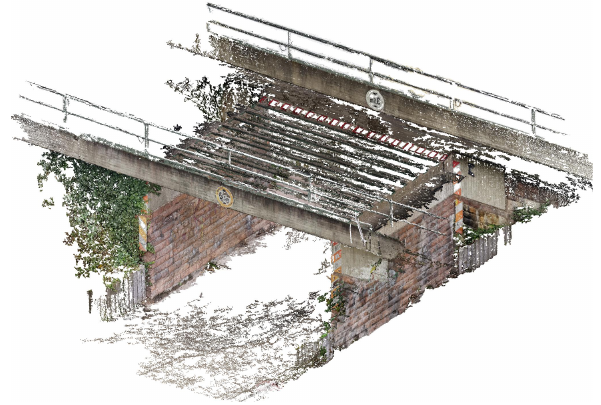
Figure 17. Small railway bridge (left) and its underside (right).